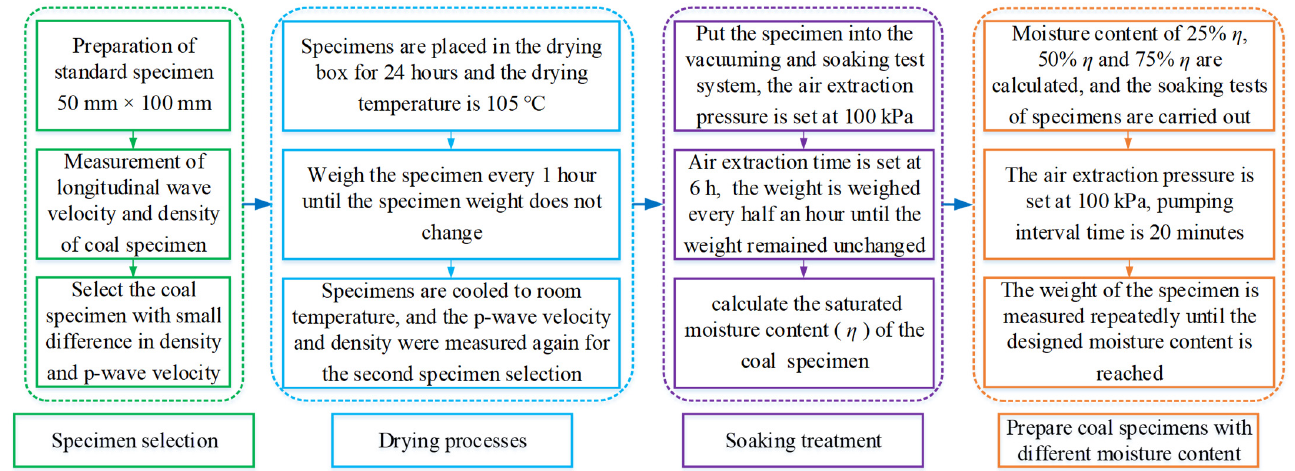
Figure 3. Preparation flow chart of coal specimens with different moisture contents.